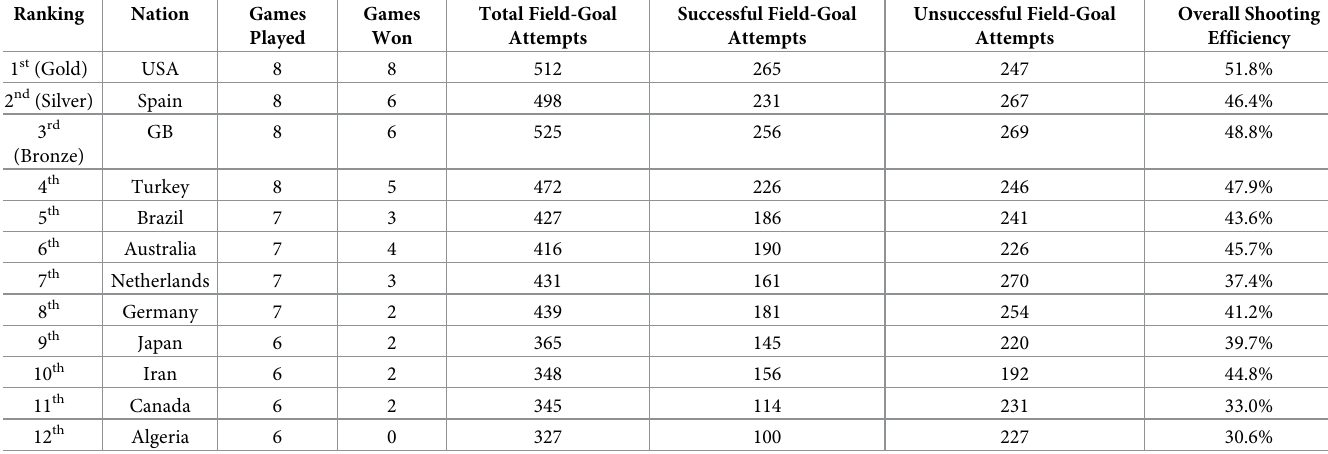
Table 1. Field-goal attempts and shooting efficiencies in competition ranking order for each nation.